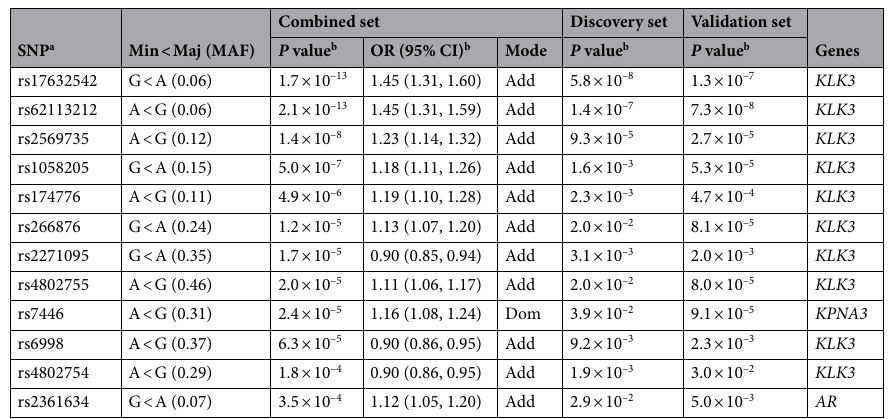
Table 1. Individual SNP effects associated with prostate cancer aggressiveness. add additive, dom dominant, MAF minor allele frequency, maj major allele, min minor allele, rec recessive, SNP single nucleotide polymorphism. a First 3 SNPs are validated SNPs (discovery p < 1 × 10 –3 and validation p < 1 × 10 –3 ). Except rs62113212, other SNPs are the hub SNPs in the 11 clusters. Linkage disequilibrium: r 2 (rs17632542, rs62113212) = 0.98. b All models adjusted for study sites and six principal components for population stratification; OR odds ratio, CI confidence